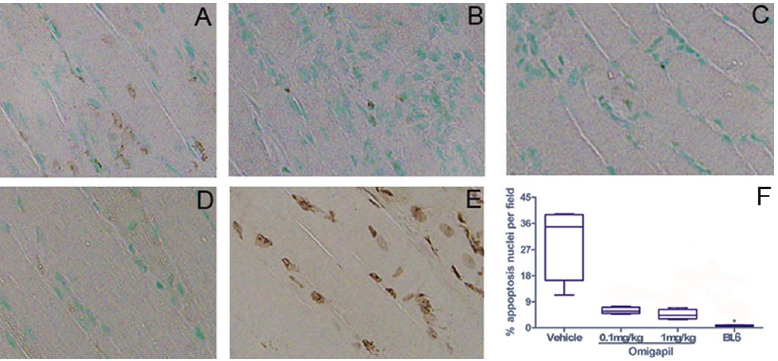
Figure 2. Apoptosis analysis of frozen tibialis anterior muscle with TUNEL assay on vehicle (A), Omigapil 0.1 mg/kg (B), Omigapil 1 mg/kg (C) treated dy 2J and BL6 control (D) groups show vehicle treated dy 2J mice had significantly more apoptosis than BL6 control (A, D, F; *P , 0.05). Both Omigapil treated groups showed less apoptosis than vehicle treated group although statistically not different (A- C, F). BL6 slide treated with TACS-Nuclease was used as positive control